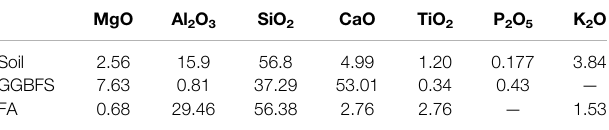
TABLE 2 | Chemical compositions of soil, GGBFS, and FA from XRF analysis